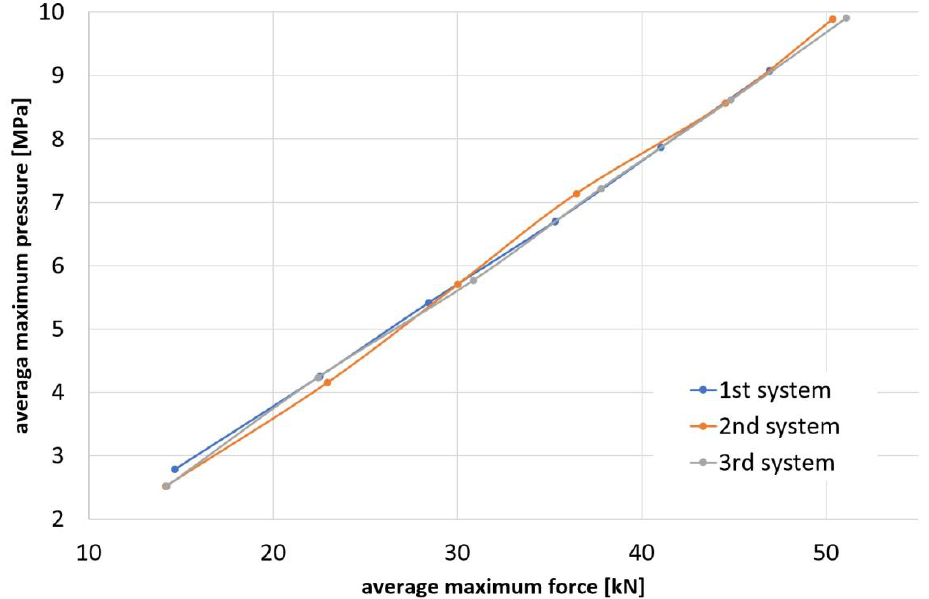
Figure 8. Mutual variability of the pressure and forces average values.